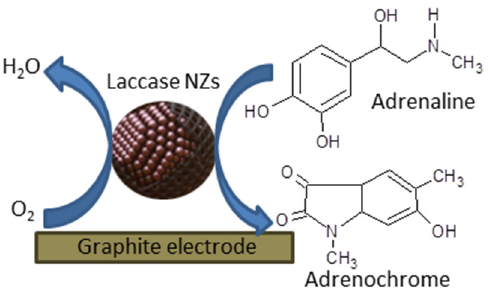
Figure 2. The principal scheme of the AD determination.